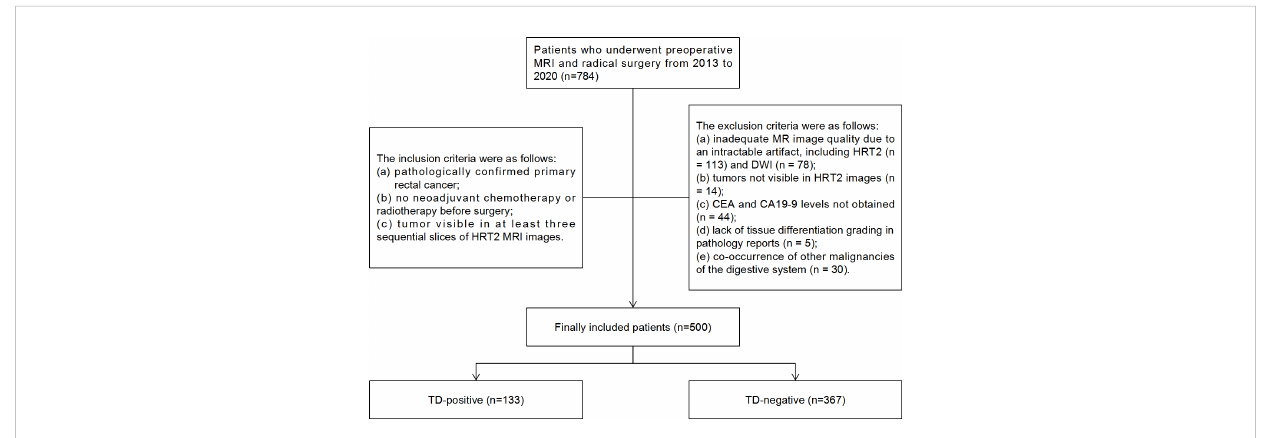
FIGURE 1 Flowchart of patient selection and TD distribution in the study. TD, tumor deposition; CEA, carcinoembryonic antigen; CA19-9, carbohydrate antigen